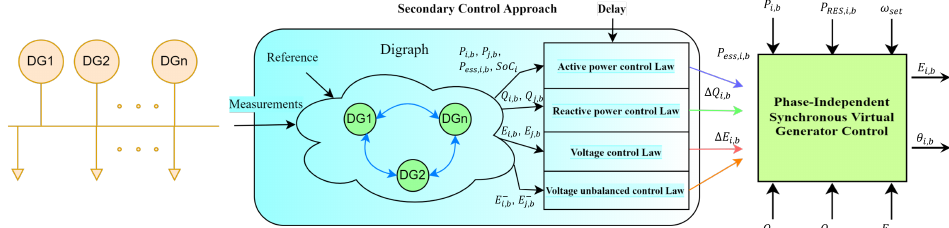
Figure 3. Diagram of the implemented secondary consensus-based and the primary phase-independent virtual generator